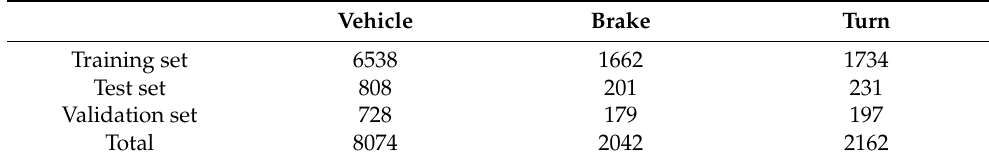
Table 1. Vehicle taillight detection dataset. Vehicle Brake Turn Training set